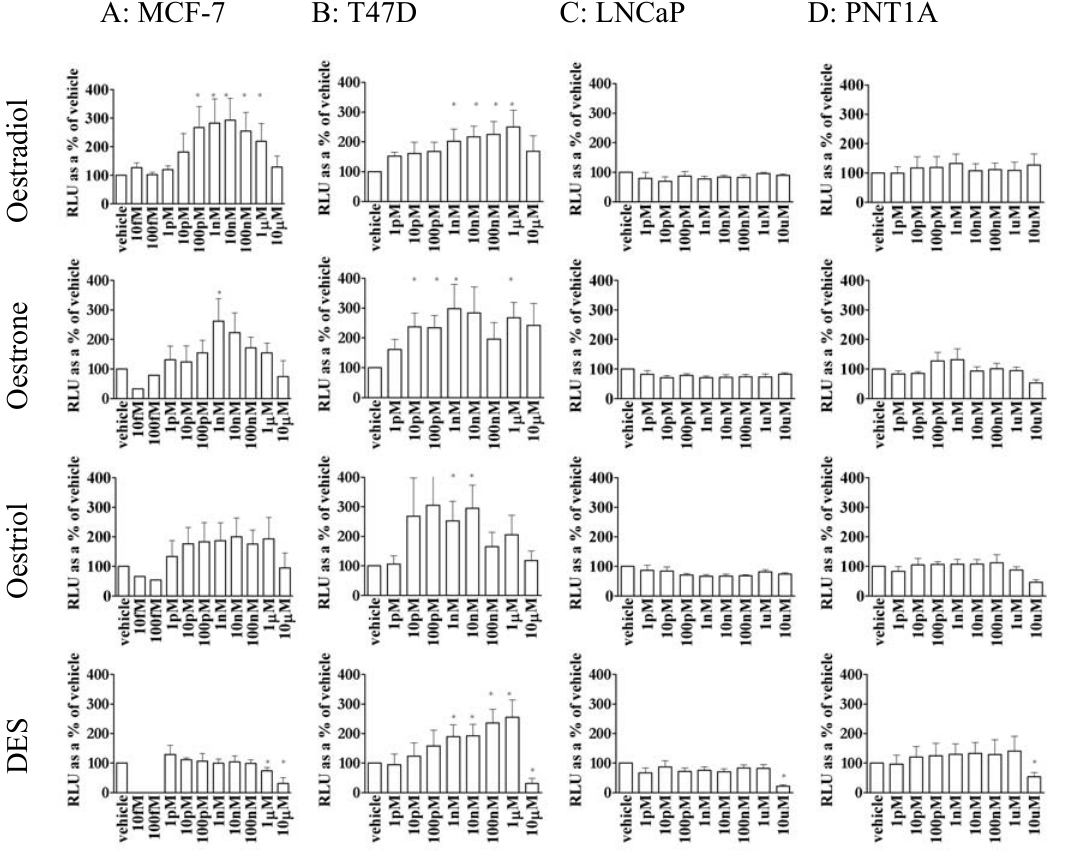
Figure 2. Oestrogen-stimulation of reporter activity in ER positive cell lines compared to basal activity in each cell line: MCF-7 cells (2A), T47D cells (2B), LNCaP cells (2C), and PNT1A cells (2D) stimulated with E2 (row 1), E1 (row 2), E3 (row 3) and DES (row 4). All the oestrogens tested slightly reduced LNCaP activity but significance is only shown for 10 μ M DES. * = significant (P < 0.05) stimulation above